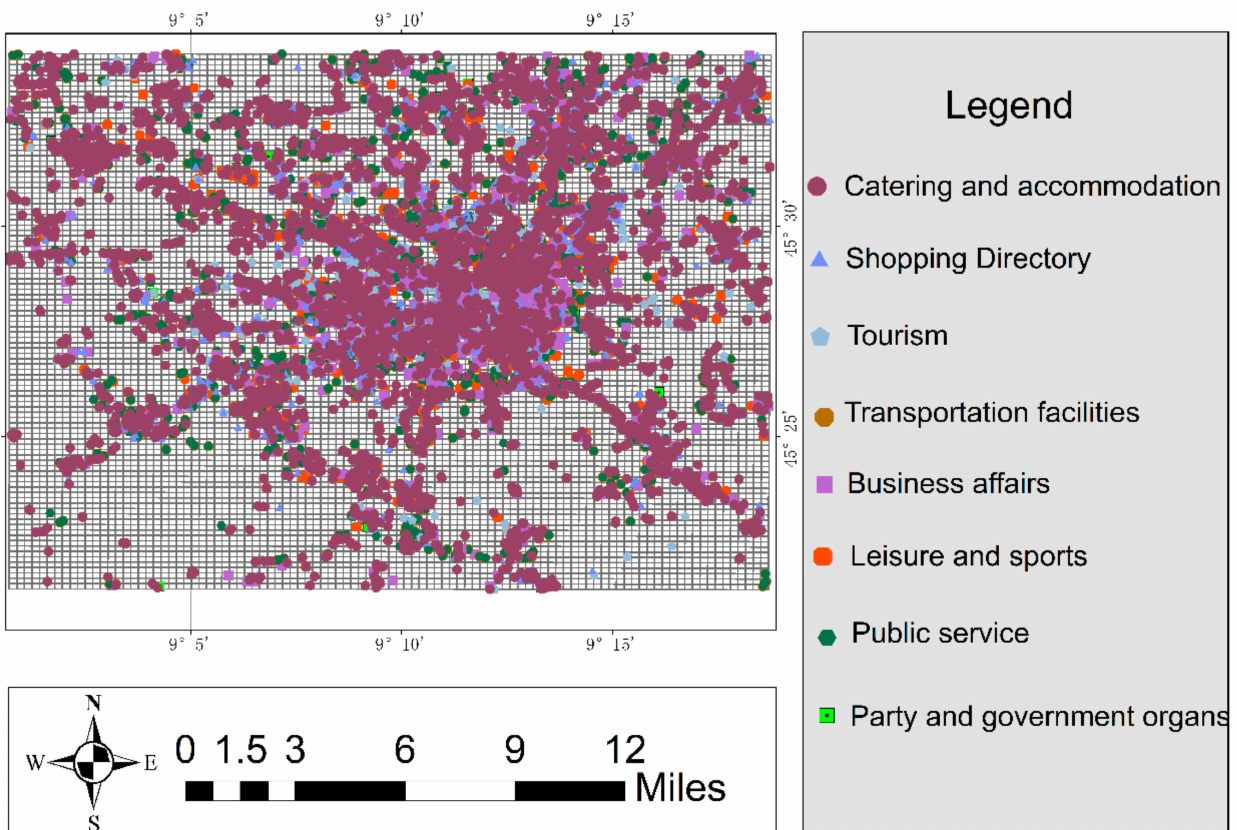
Figure 4. The overlay map of the POI dataset with the 10,000